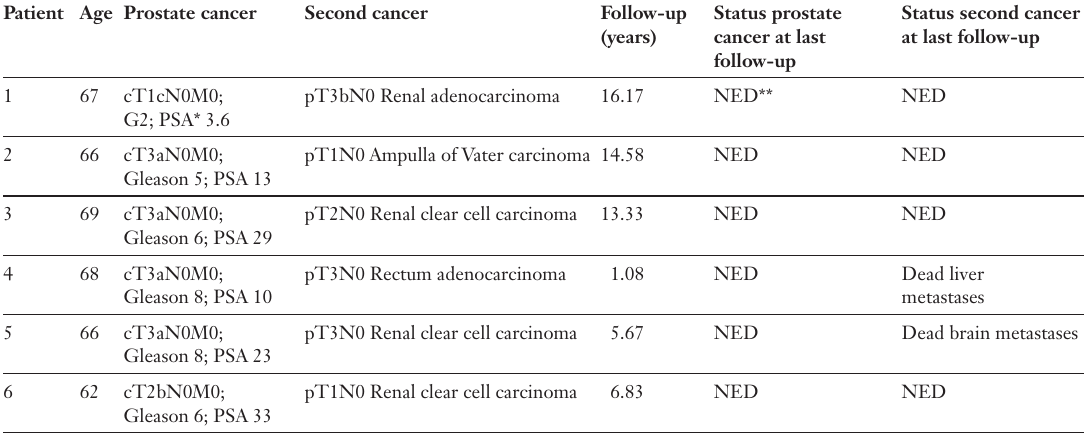
Clinical features and outcome for the six patients with incidental second cancers diagnosed after staging workup for prostate